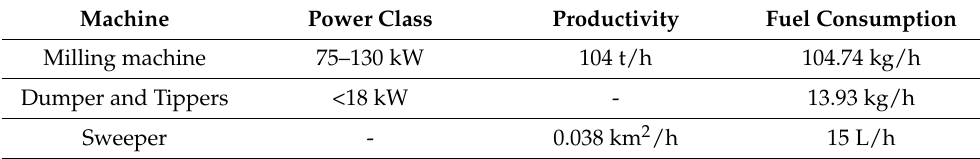
Table 6. Machinery